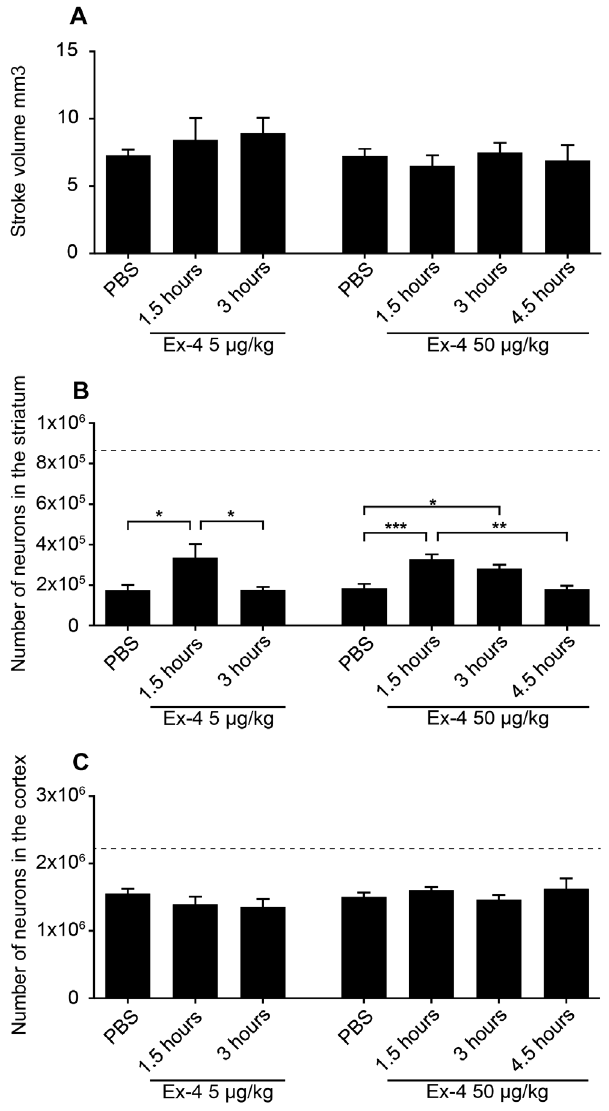
Figure 2. Neuroprotective effects of Ex-4 in normal, adult mice (Studies 1–2). Stroke volume at one week after 5 m g/kg or 50 m g/kg of Ex-4 administration (A). Number of surviving neurons in striatum (B) and cortex (C) at one week after 5 m g/kg or 50 m g/kg Ex-4 administration at 1.5, 3 and 4.5 hours after MCAO. The dashed lines on B, C indicate the number of neurons in the contralateral, corresponding intact brain areas. Data are presented as means 6 SEM. *, ** and *** denote p , 0.05, p , 0.01 and p , 0.001 respectively.